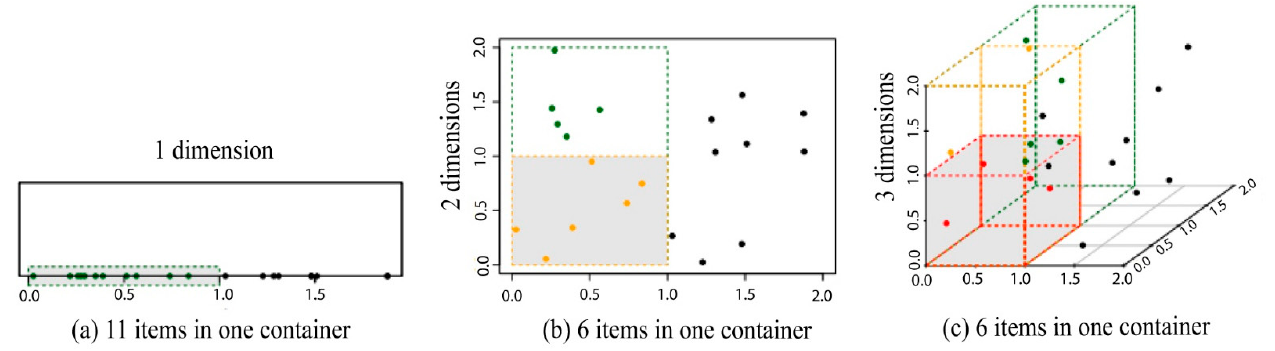
Figure 1. An instance of item representation in different feature spaces. ( a ) Shows data points are comparatively closely packed on one axis. ( b ) Demonstrates data points in a two-dimensional space stretched in the direction of the longitudinal axis so that the distances between points become larger. ( c ) Represents data points are further stretched in a three-dimensional